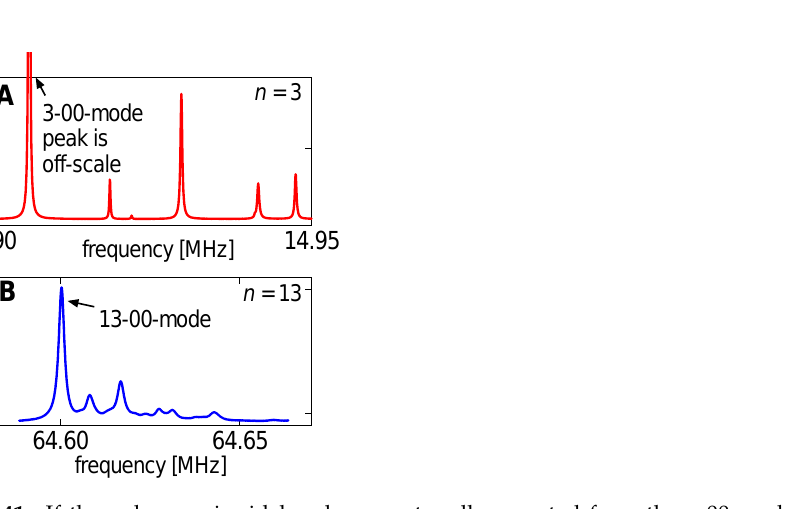
Figure 41. If the anharmonic sidebands are not well separated from the n -00-mode, there will be coupling. The frequency and the bandwidth of the n -00-mode then vary unsystematically in experiment. In ( A ), the anharmonic side bands are well separated from the 3-00-mode. The 13-00- mode shown in ( B ) is of little use for